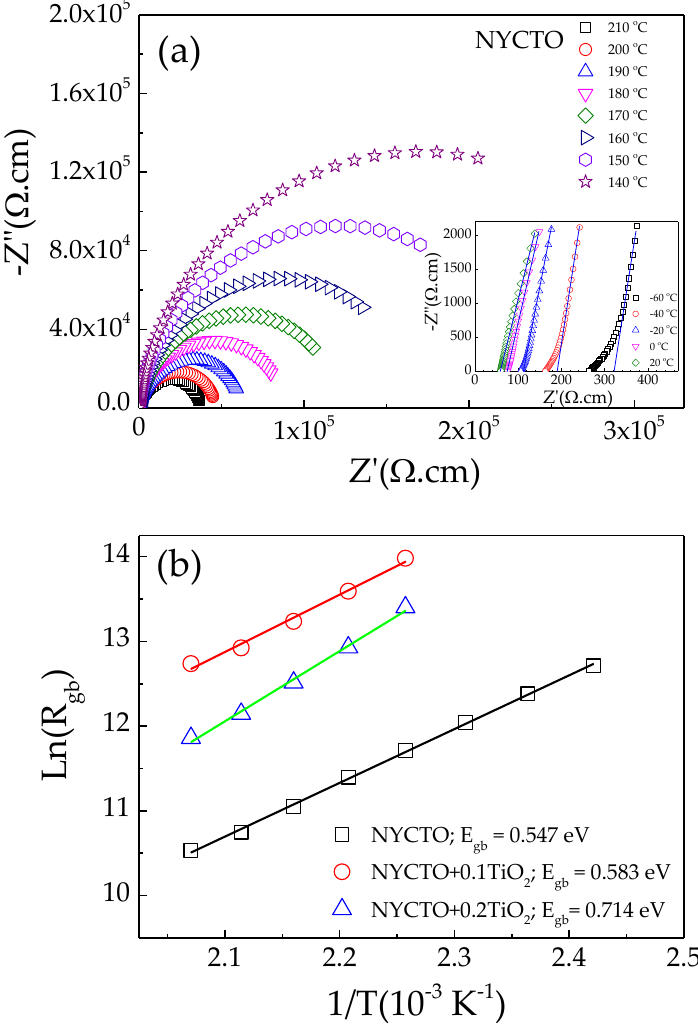
Figure 9. ( a ) Impedance complex plane plots (Z*) of NYCTO ceramic at various temperature (140 – 210 °C). ( b ) Arrhenius plot for grain boundary conductivity ( R gb ).